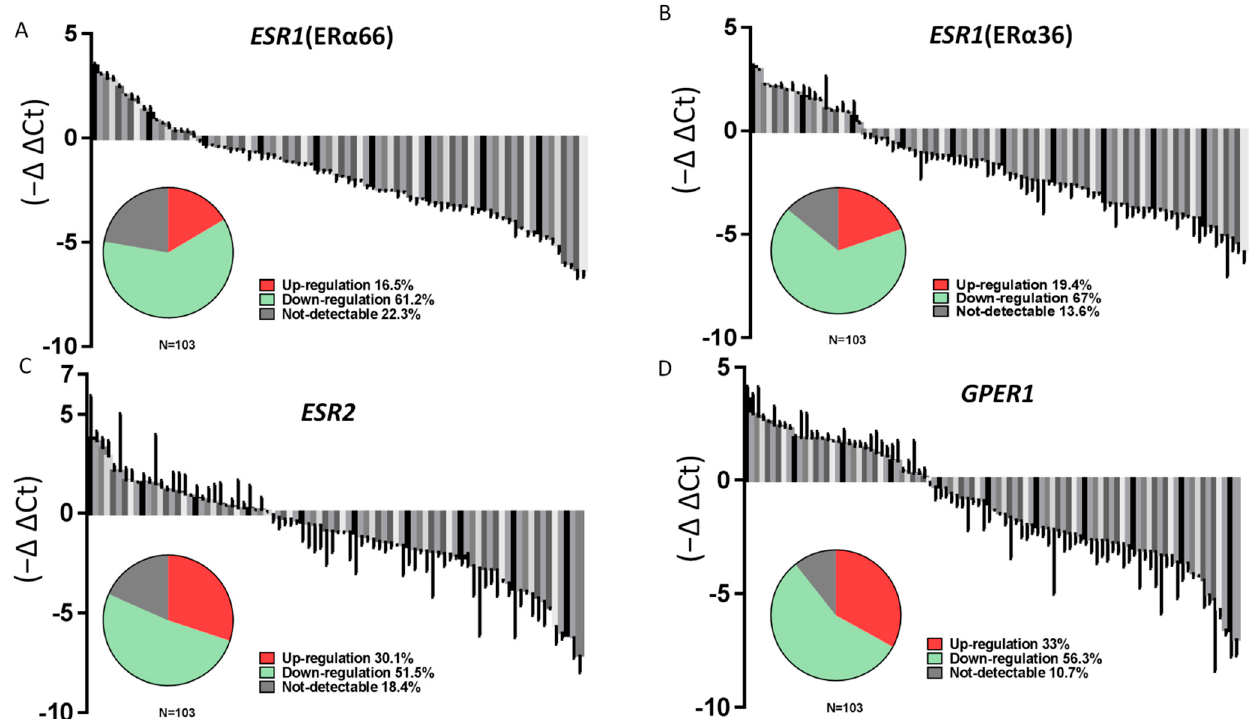
Figure 2. The majority of patients with PTC show lower ERs expression in cancer specimens than in adjacent normal thyroid tissues. Relative mRNA expression levels of ( A ) ER α 66, ( B ) ER α 36, ( C ) ER β , and ( D ) GPER1 in PTC ( n = 103) samples normalized to that in adjacent normal tissues (T/N fold change). The pie charts show the proportion of samples with upregulated, downregulated, and undetectable expression .